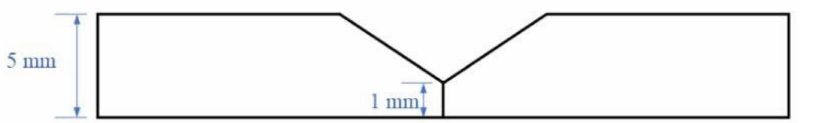
Figure 2. Schematic diagram of the longitudinal cross-sectional dimensions of a butt-welded